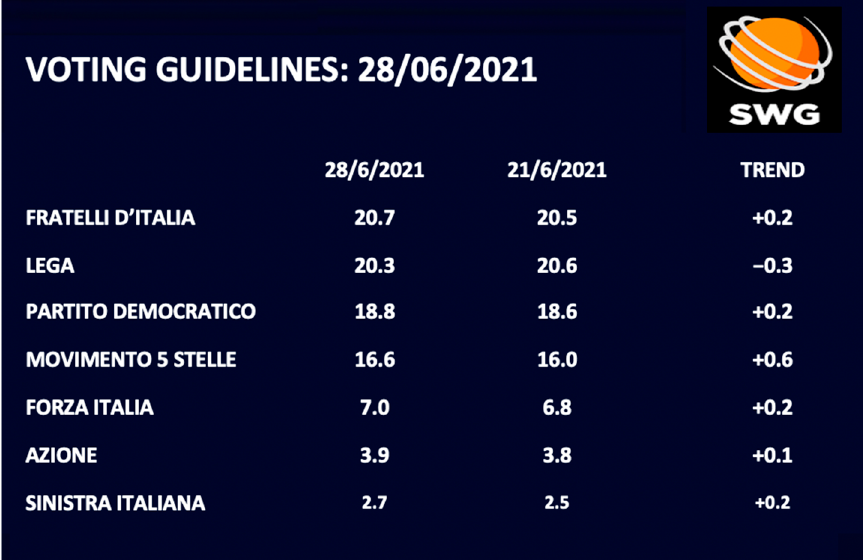
Figure 4. Polls retrieved by Swg, June 2021.